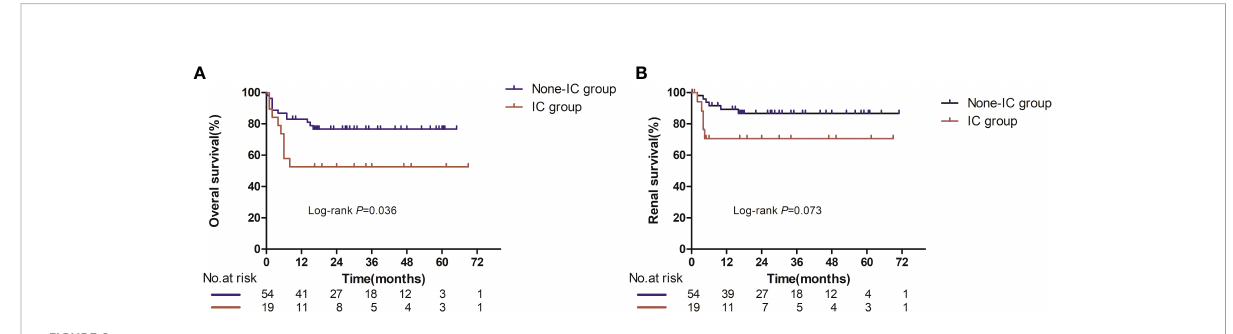
FIGURE 2 Overall survival (A) and renal survival (B) in evaluable patients between the IC and non-IC group. Number at risk at certain time points is shown in panel below